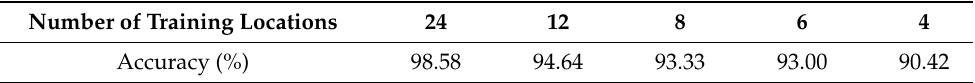
Table 8. The recognition accuracy of different numbers of pre-trained